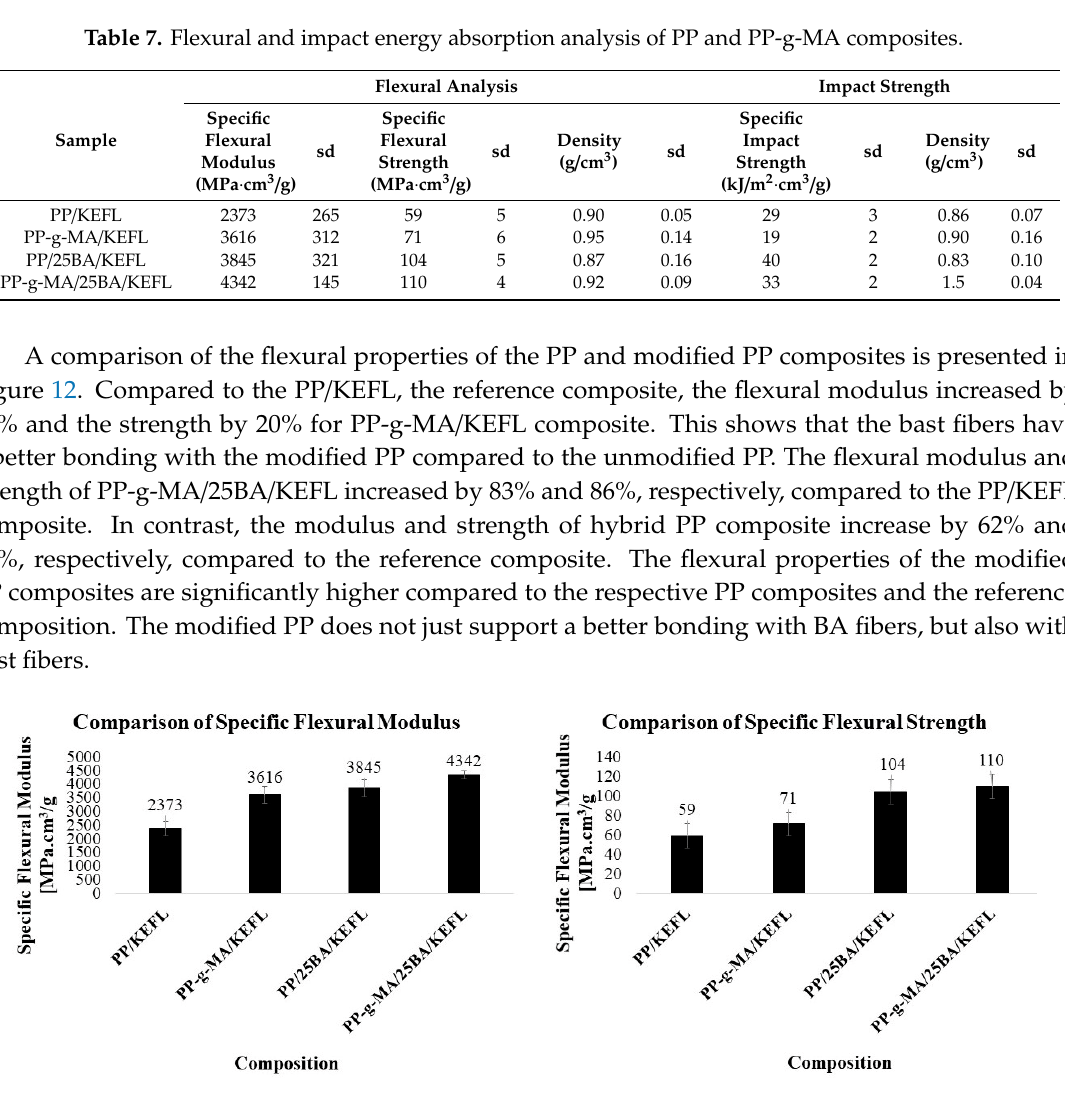
Figure 12. Comparison of the flexural properties of PP composites with modified PP composites.